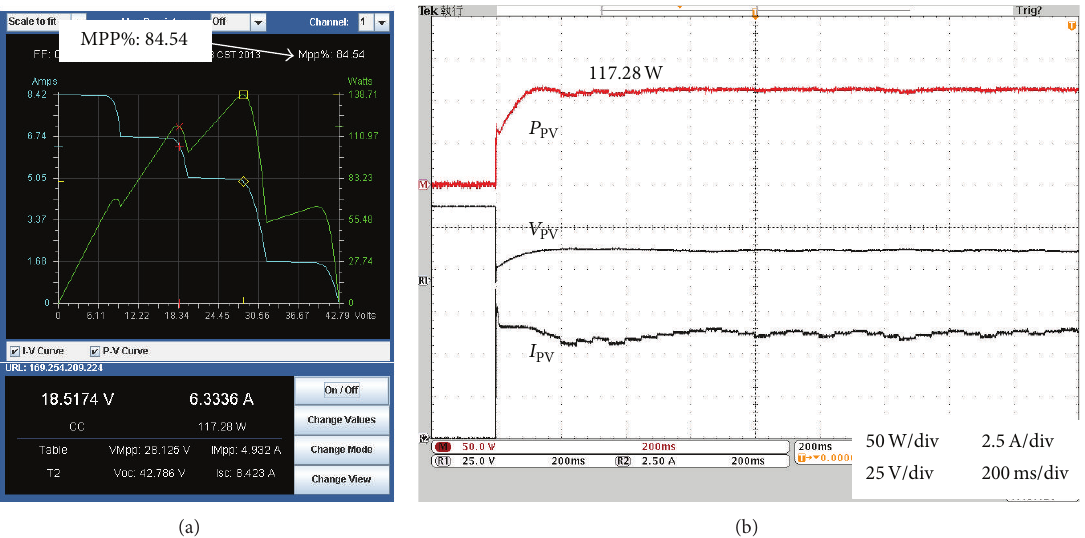
Figure 10: Experimental results for P&O algorithm under partial shading of 1.0kW/m 2 , 0.8 kW/m 2 , 0.2 kW/m 2 , and 0.6 kW/m 2 ; (a) 𝐼 - 𝑉 and 𝑃 - 𝑉 curves and (b) waveforms of PV power, voltage, and